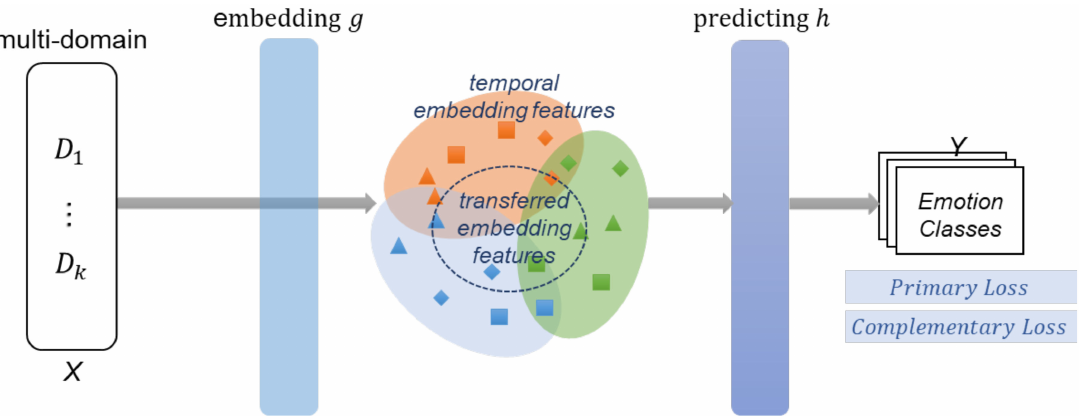
Figure 1. Supervised multi-domain adaptation of the multi-path and group-loss-based network (MPGLN) speech emotion recognition (SER). The model generates the temporal embedding feature and the transferred embedding feature for the speech segment and learns based on multiple